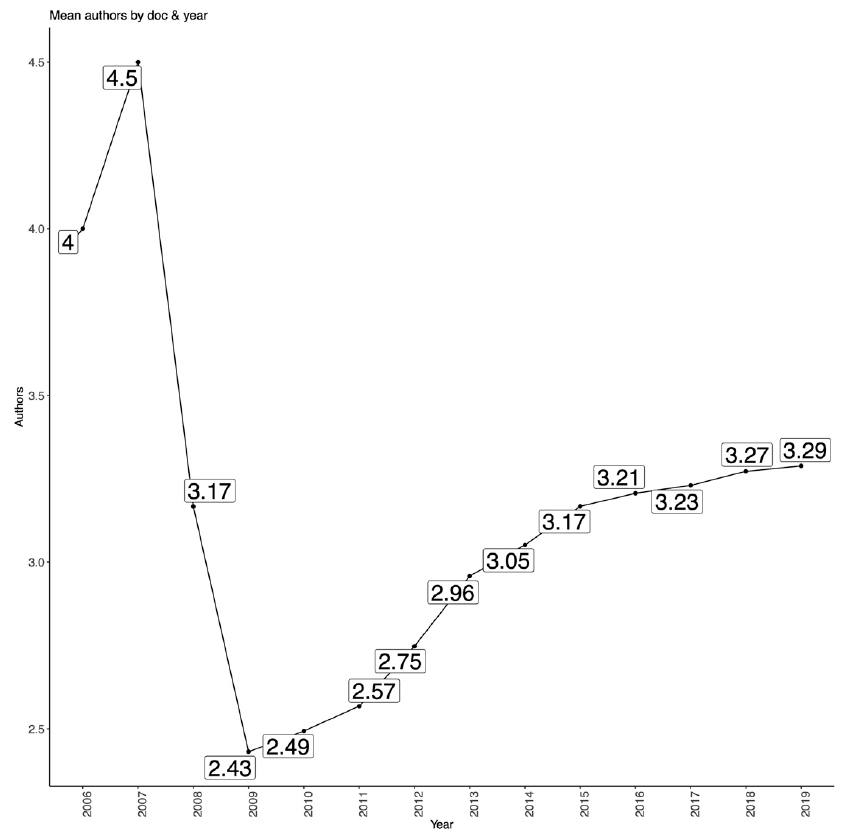
Figure 4. Average number of authors per document.